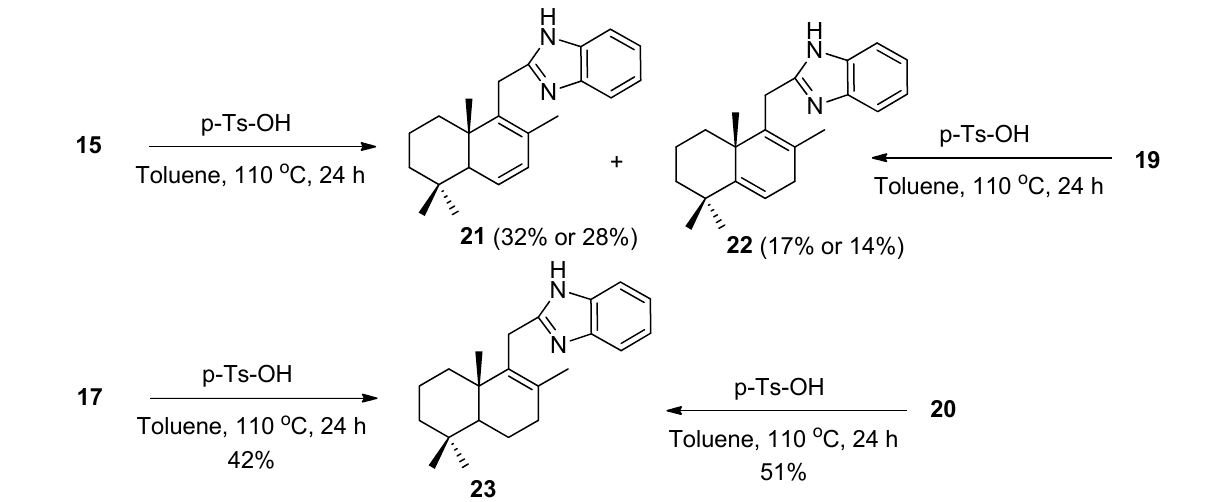
Scheme 3. Synthesis of 2-substituted benzimidazoles 21 – 23 from monoacylamides 15 , 17 , 19, and